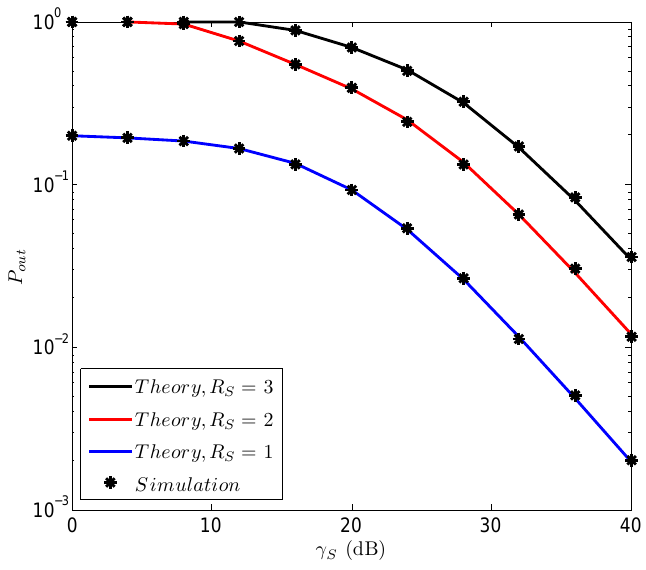
Figure 4. P out vs. γ S with various R s . ¯ γ SD = η = 0.8.